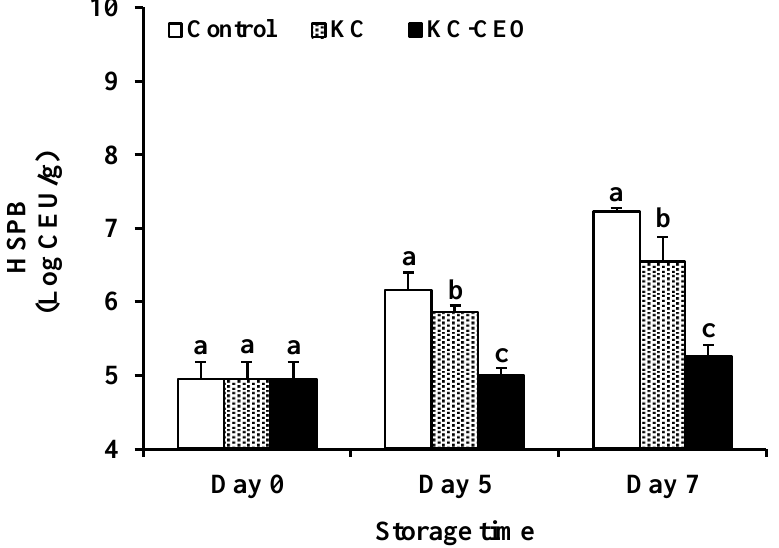
Figure 3. Impact of KC-based coatings on the number of HSPB in pork meat during refrigerated storage (4 °C). KC , kappa-carrageenan; CEO, cinnamon essential oil; HSPB, H 2 S-producing bacteria. Different letters for data points on each day represent significant differences ( p < 0.05).